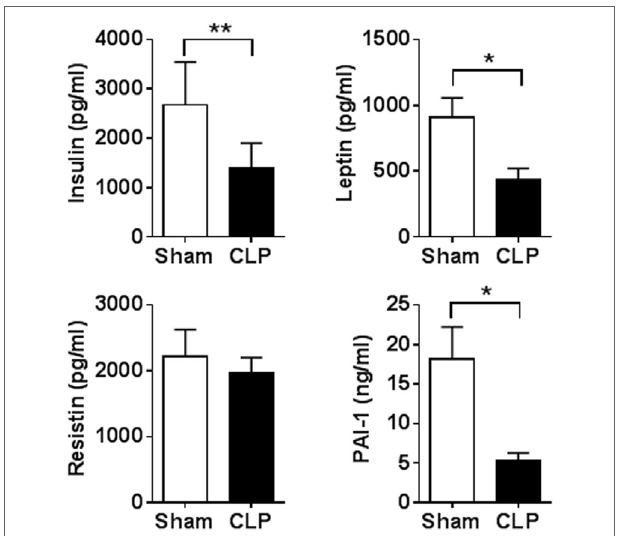
FigUre 3 | Cecal ligation and puncture (CLP)-sepsis alters metabolic markers. Serum levels of insulin, leptin, and plasminogen activator inhibitor-1 (PAI-1) were decreased in mouse sepsis survivors. * P = 0.0157 (leptin), * P = 0.0109 (PAI-1), ** P = 0.0023, Student’s t -test, n = 8–9 per